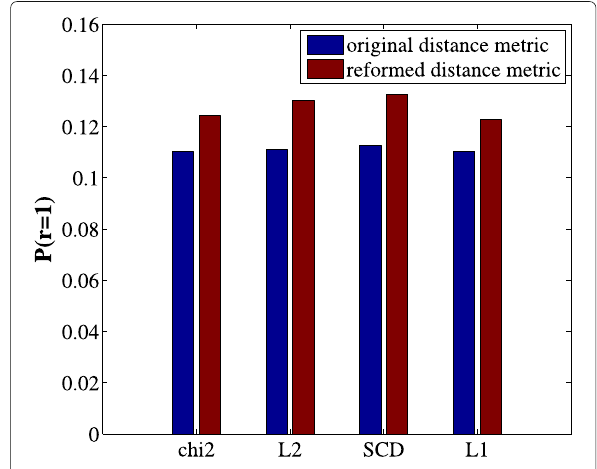
Fig. 6 Coherence distribution of VGG features